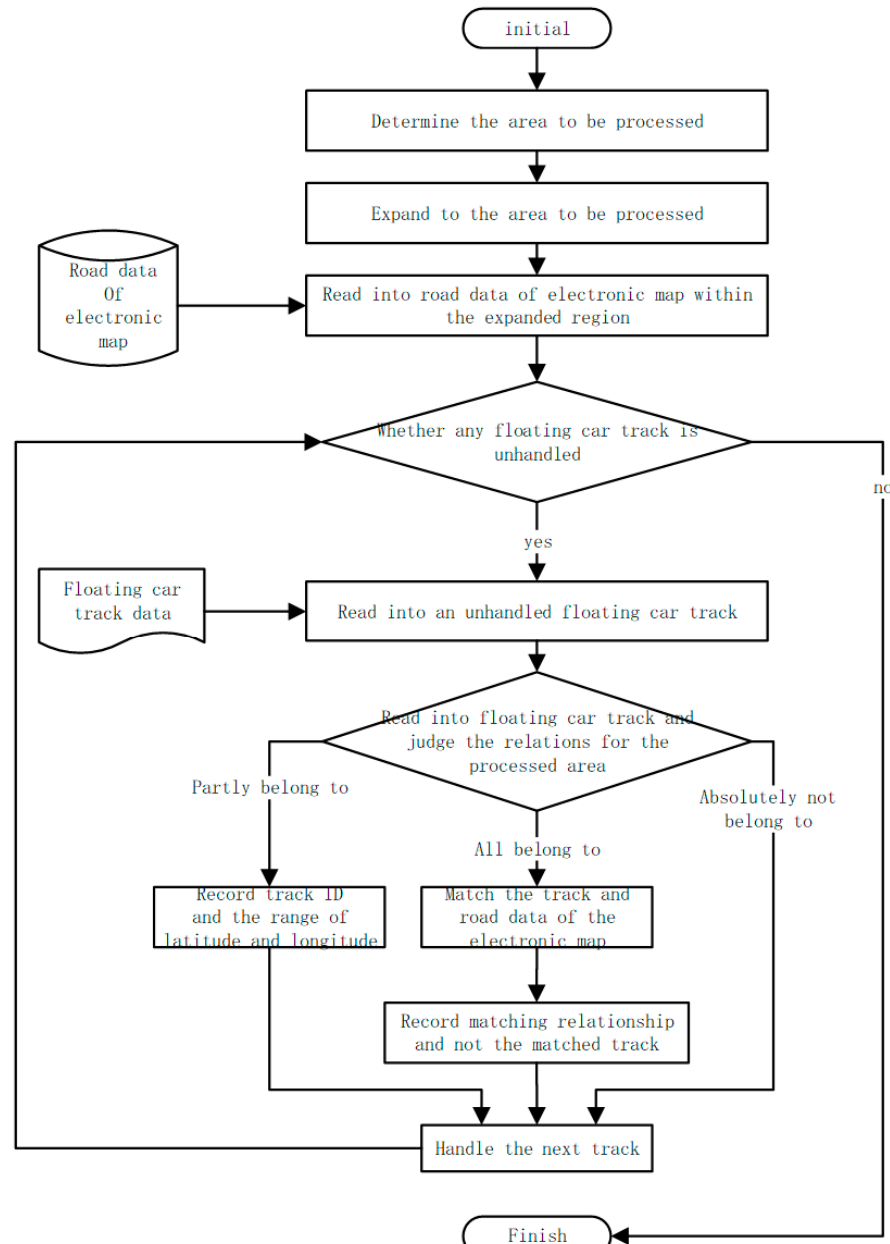
Figure 4. Workflow for the first map algorithm.